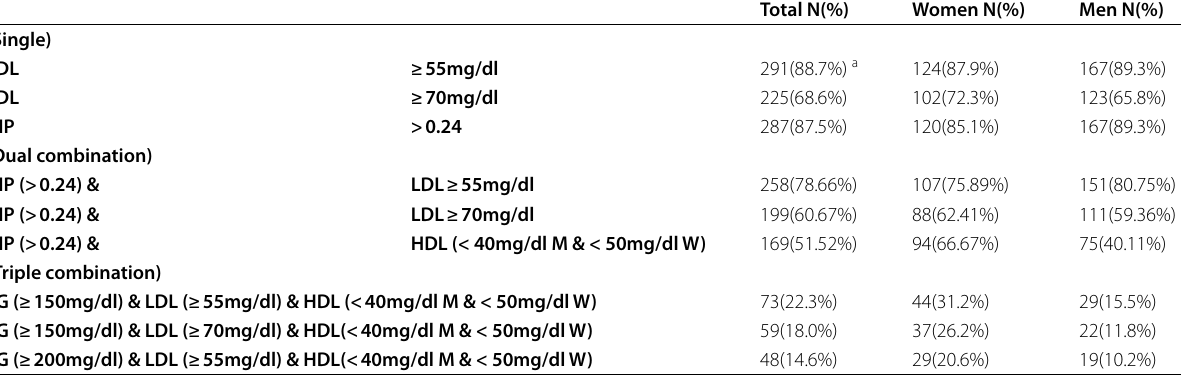
Table 4 The most prevalent patterns of dyslipidemia in patients with type 2 diabetes and CAD